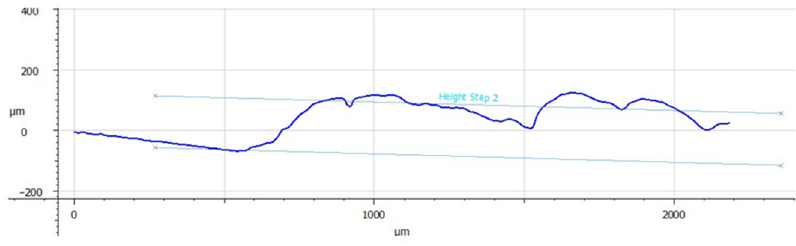
Figure 13. Surface profile measurement (average height is measured in the section).